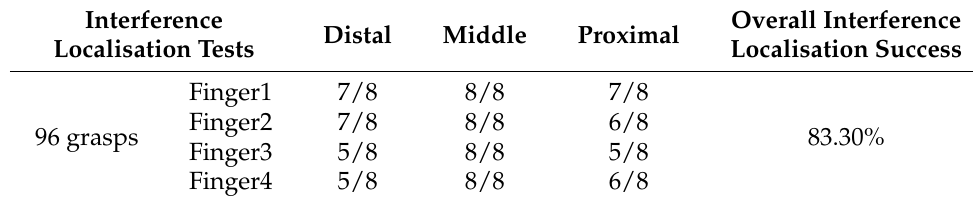
Table 2. Interference localization experiment result.